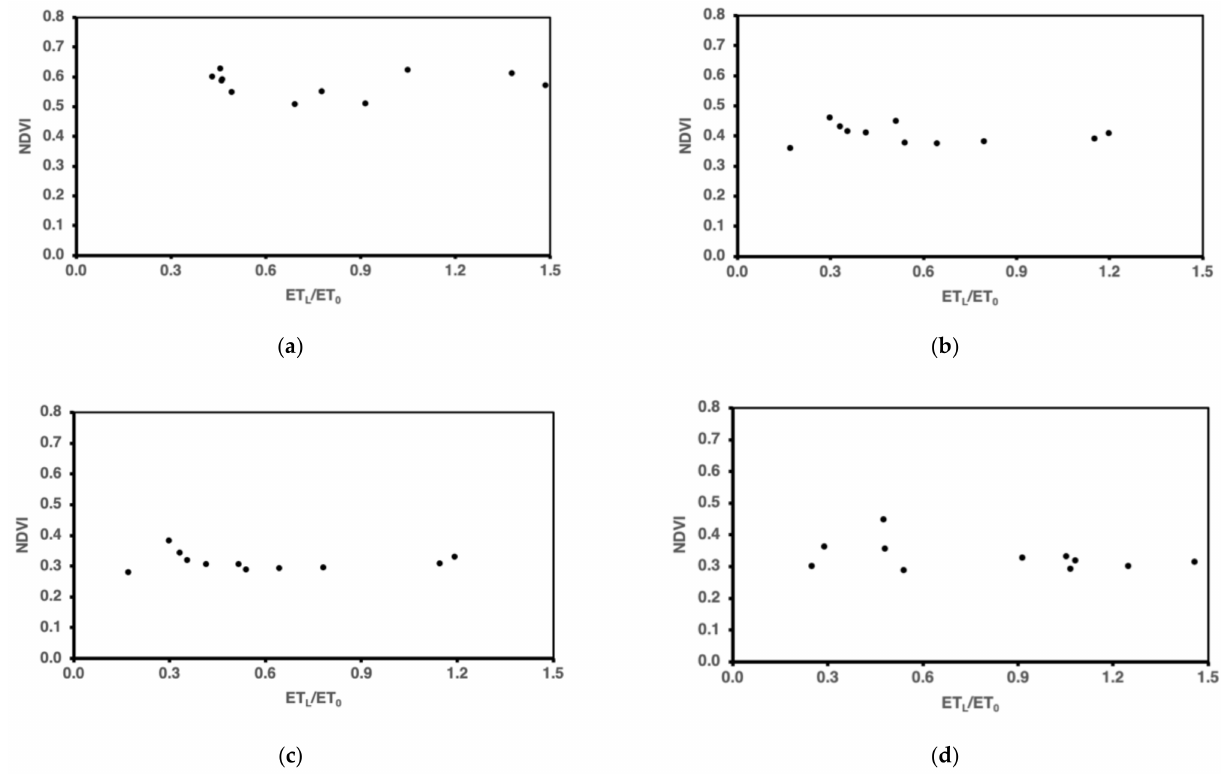
Figure 13. Variation of average NDVI values with bulk irrigation depths in the 2019 irrigation season. ( a ) Trees, ( b ) shrubs, ( c ) flowers, ( d )